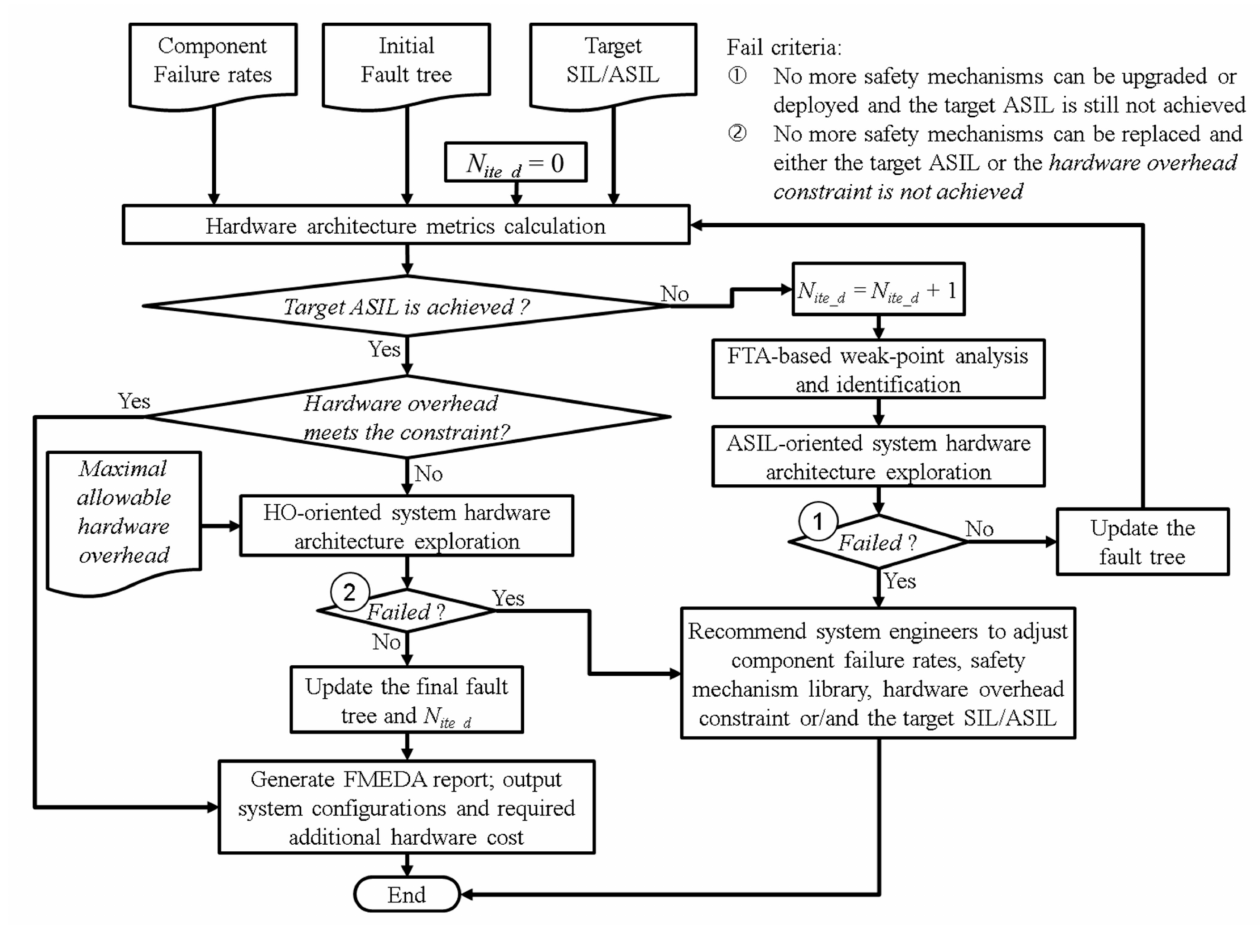
Figure 2. Flowchart of the proposed safety-oriented system HW architecture exploration